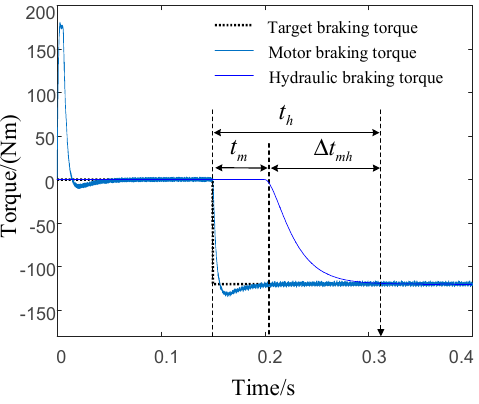
Figure 7. Dynamic response characteristics of the HBS and the motor braking system (MBS).